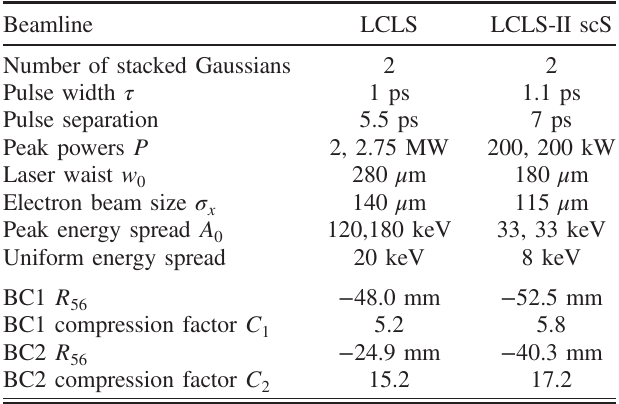
TABLE V. Laser heater shaping parameters to suppress caustic formation at the LCLS and at the LCLS-II scS.